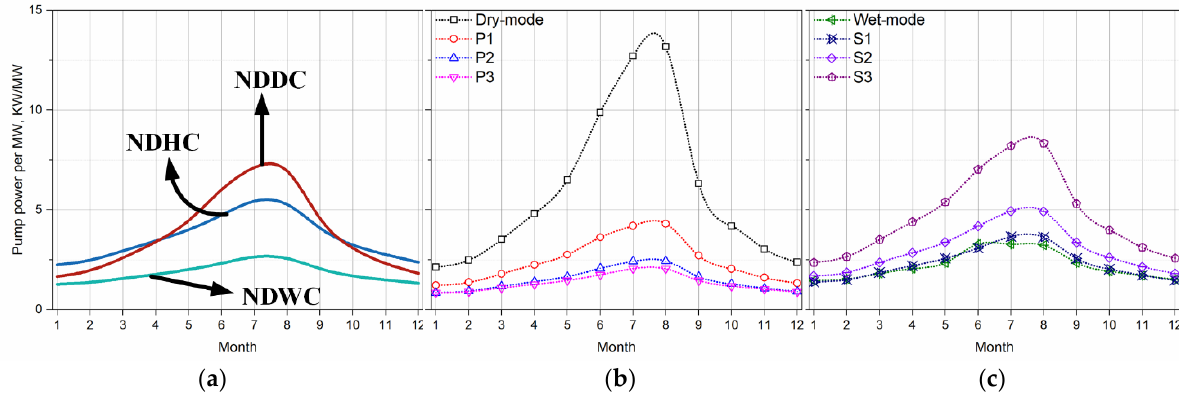
Figure 7. Power of pumps for different cooling systems in kW/MW. ( a ) NDDC, NDWC and NDHC, ( b ) parallel mode of NDHC, ( c ) serial mode of NDHC.